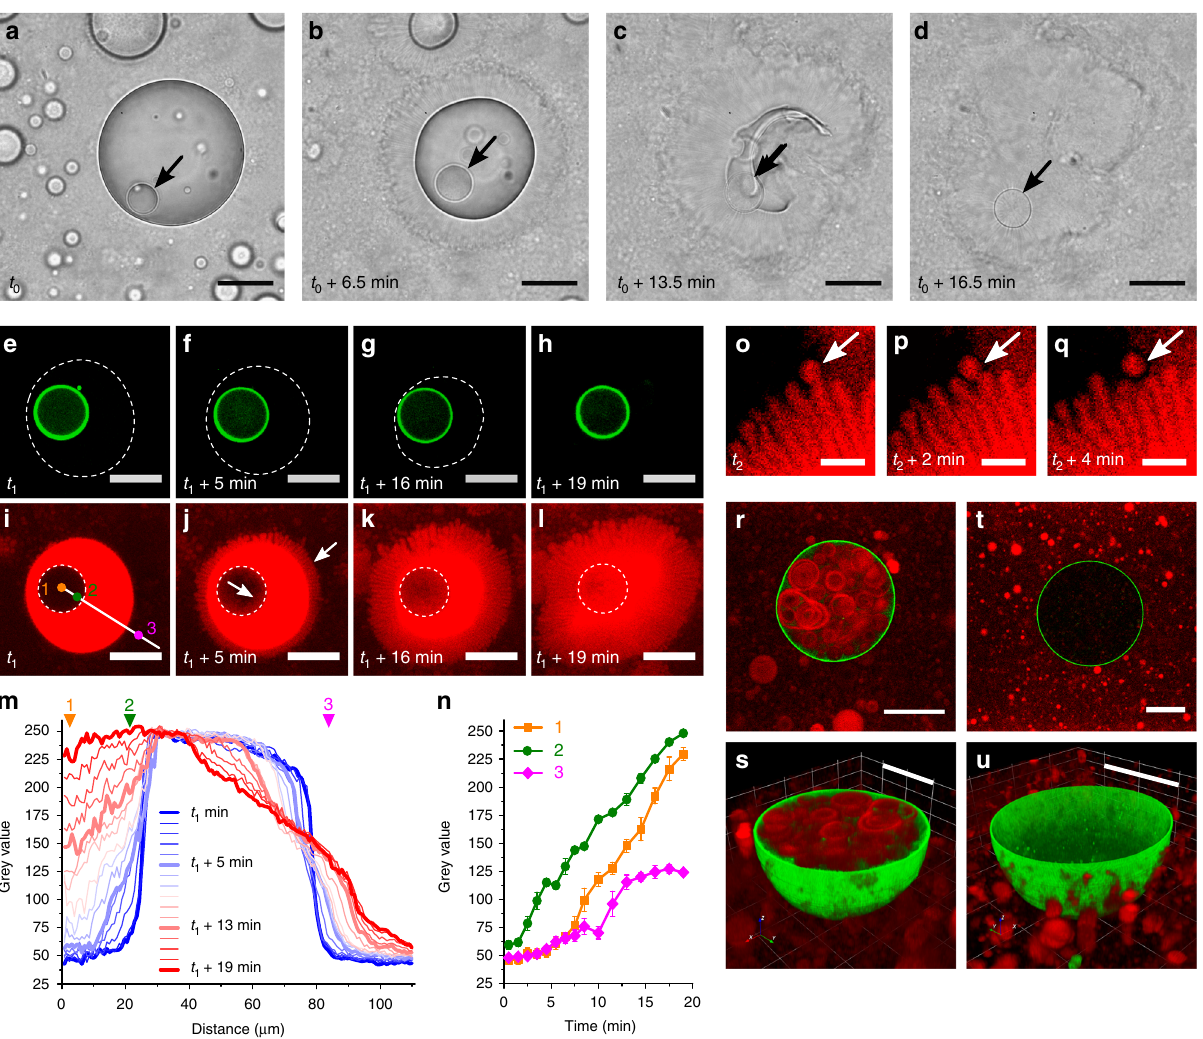
Fig. 3 Disassembly and transformation in self-recon fi gurable host – guest protocells. a – d Time series of optical microscopy images showing enzyme- mediated disassembly and transformation of an individual GOx-containing proteinosome/myristic acid micelle coacervate droplet in the presence of glucose (10 mM; time t 0 ). Arrow shows location of the single guest proteinosome (low-optical contrast) that remains intact as the host micelle coacervate droplet (high optical contrast) is progressively disassembled and transformed into a corona of elongated fatty acid vesicles (low-optical contrast). The proteinosome is released as an intact micro-capsule (Supplementary Movie 2); scale bars, 50 μ m. e – l As for a – d , but imaged by confocal fl uorescence microscopy showing presence of intact FITC-labelled guest proteinosome at time t 1 (green ring in e – h , dashed line in i – l ) within a disassembling Nile Red- doped micelle coacervate droplet (dashed line in e – h , red object in i – l ). Progressive outgrowth of red fl uorescent elongated protrusions occurs from the surface of the deconstructing micelle coacervate droplet, along with inward contraction into the proteinosome interior (white arrows) (Supplementary Movie 3); scale bars, 50 μ m. Numbers and white line in i refer to line pro fi le and speci fi c locations used to measure changes in red fl uorescence (see m , n ). m , n Spatial- ( m ) and time ( n )-dependent changes in red fl uorescence intensities for the host – guest protocell shown in i – l . Line pro fi les are shown in m (white line in i ), and intensity values measured at three speci fi c locations (1, 2, 3 in i ) are shown in n . Error bars in n represent the standard deviation of the fl uorescence intensity. o – q High-magni fi cation confocal fl uorescence microscopy images showing detachment of spherical fatty acid vesicles at the end of elongated protrusions formed at the droplet/water interface over a period of 4 min (white arrows); scale bars, 10 μ m. r , s 2D confocal microscopy image ( r ) and 3D reconstruction ( s ) of a single proteinosome containing multiple fatty acid vesicles after enzyme-mediated self-induced transformation of a FITC-labelled proteinosome/Nile Red-doped micelle coacervate nested protocell. t , u As for r , s , but after a more rapid decrease in pH (addition of HCl) showing absence of vesicle sequestration in the reconstructed hybrid protocell; scale bars, 20 μ